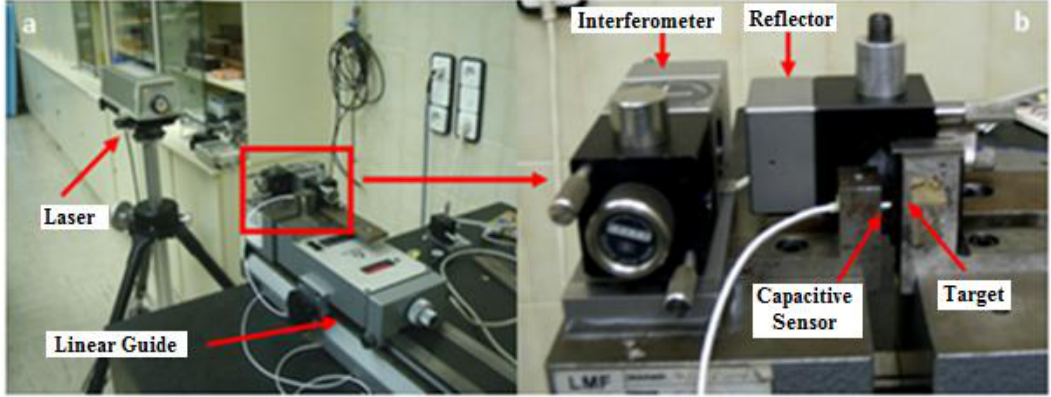
Figure 20. Experimental setup of sensor’s characterization